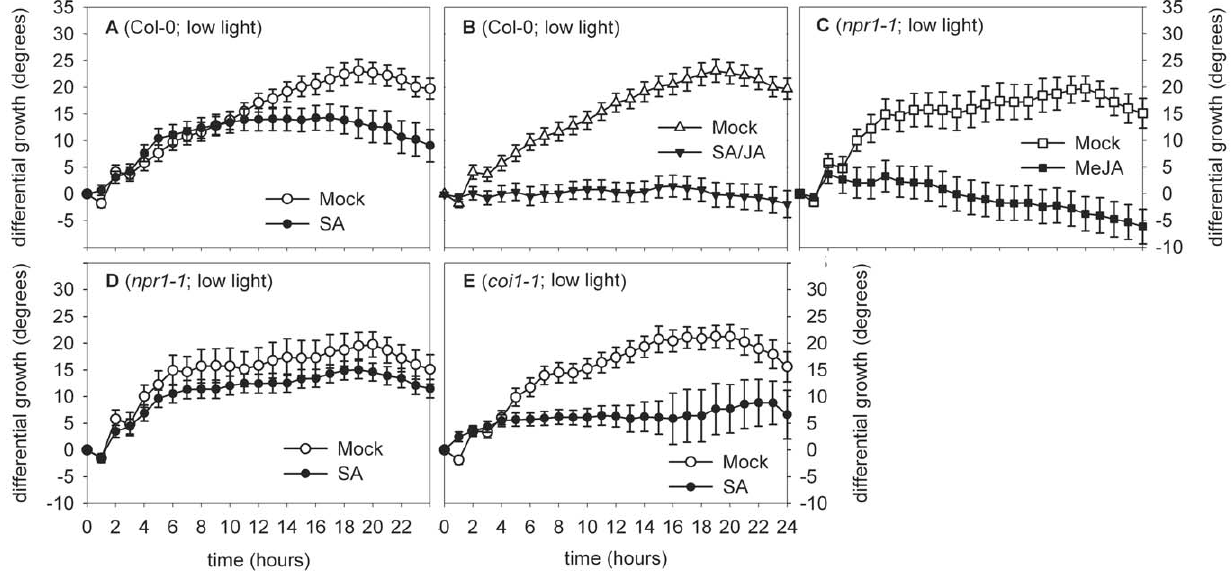
Figure 4. SA and SA/MeJA effects on light-controlled leaf movements. (A,D,E) Effect of 1 h pre-treatment with 1 mM SA (closed circles), (C) 100 m M MeJA (closed squares) and (b) the combination SA + MeJA (SA/MeJA, 100 m M, closed squares) compared to mock (open symbols), on Arabidopsis petiole angles in low light. (A,B) Col-0 wild type; (C,D) npr1-1 ; (E) coi1-1 . Values were pair-wise subtracted per time point for the corresponding response in control conditions. Error bars represent SE, n . 12